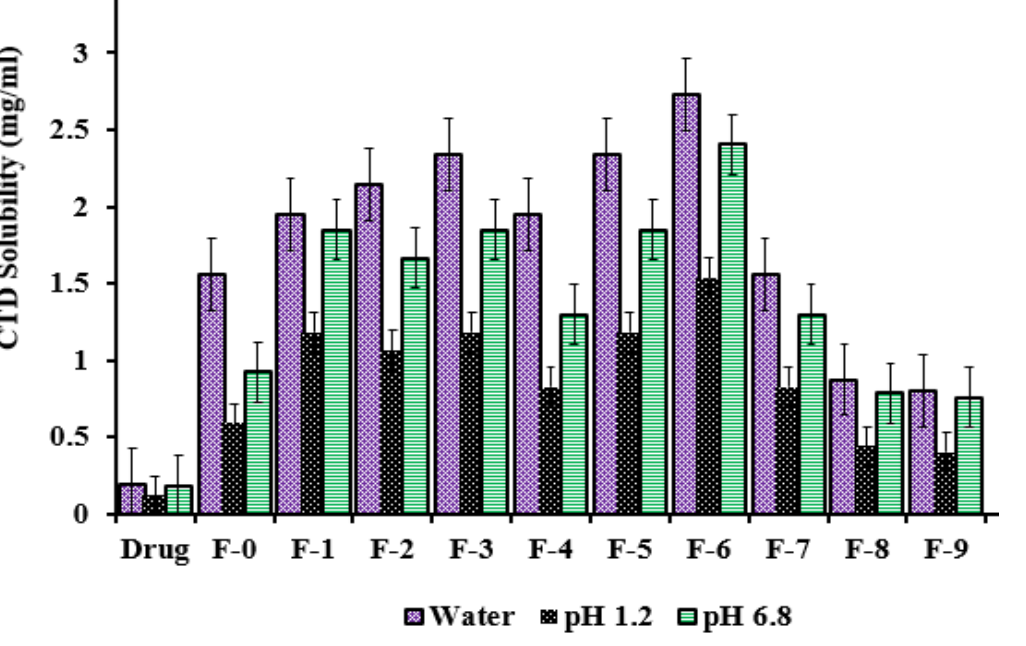
Figure 6. Solubility profiles of drug and fabricated nanosponges in water, pH 1.2 and 6.8.